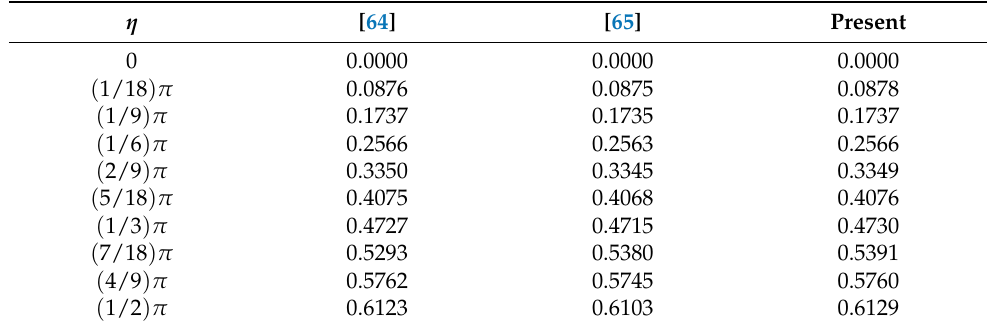
Table 3. Comparison of the outcomes for C f at Pr = 7, (cid:118) 1 = (cid:118) 2 = 0, We = 0, and M =